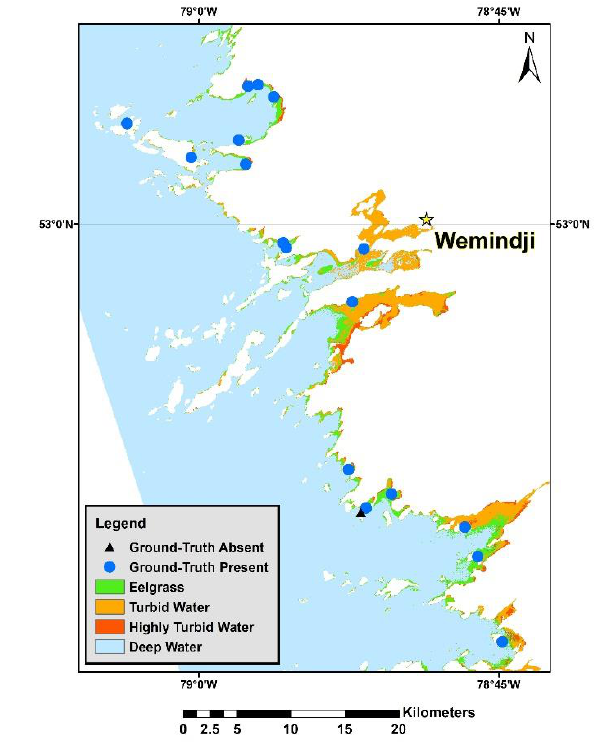
Figure 7. Classified image produced by applying the Random Forests classifier to both Landsat-8 OLI images.